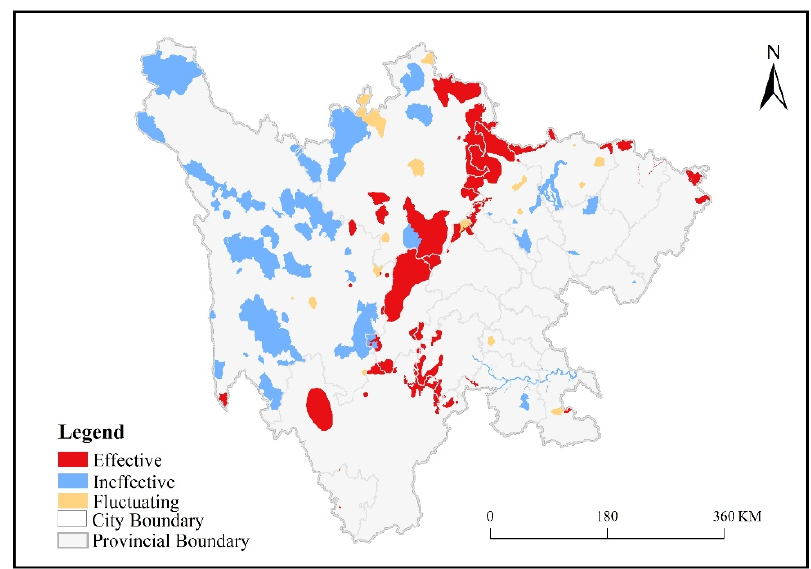
Figure 7. Types of variation in protection effectiveness.